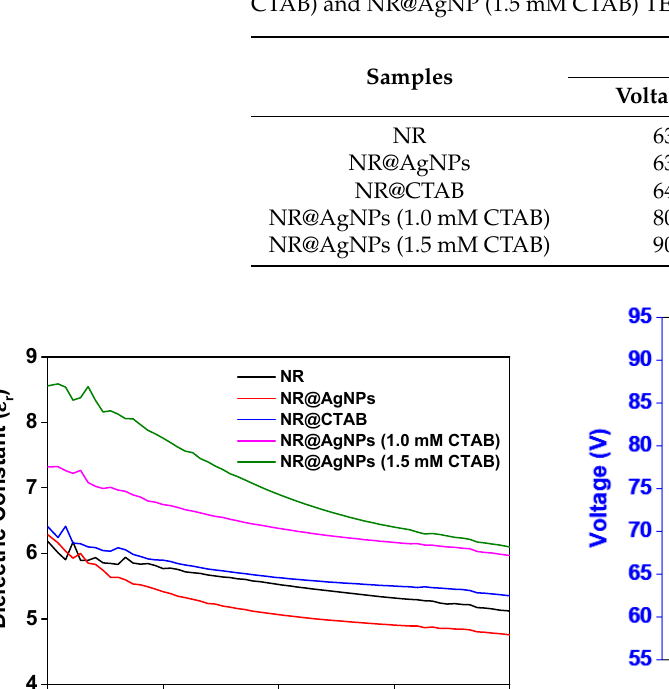
Figure 6 . Electrical outputs: ( a ) voltage and ( b ) current of NR, NR@AgNP (without CTAB), NR@CTAB (no Ag), NR@AgNP (1.0 mM CTAB) and NR@AgNP (1.5 mM CTAB) TENGs. Table 1. Electrical output voltage and current of NR, NR@AgNP (without CTAB), NR@AgNP (1.0 mM